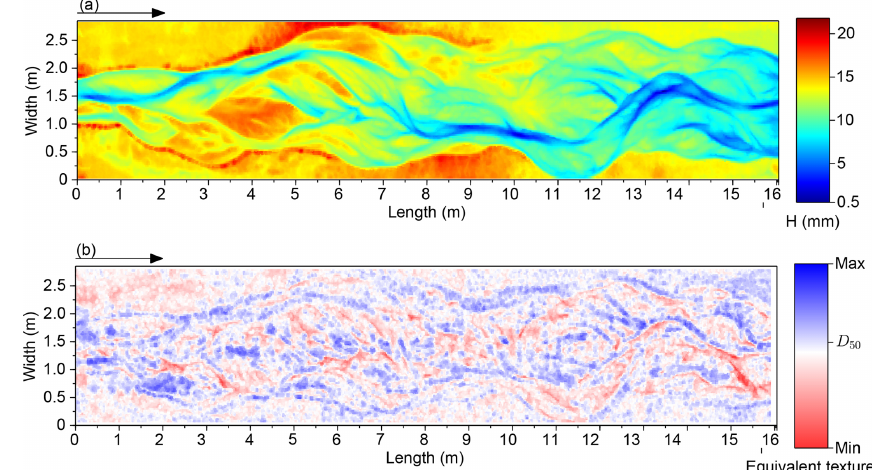
Competing interests. The authors declare that they have no con- flict of